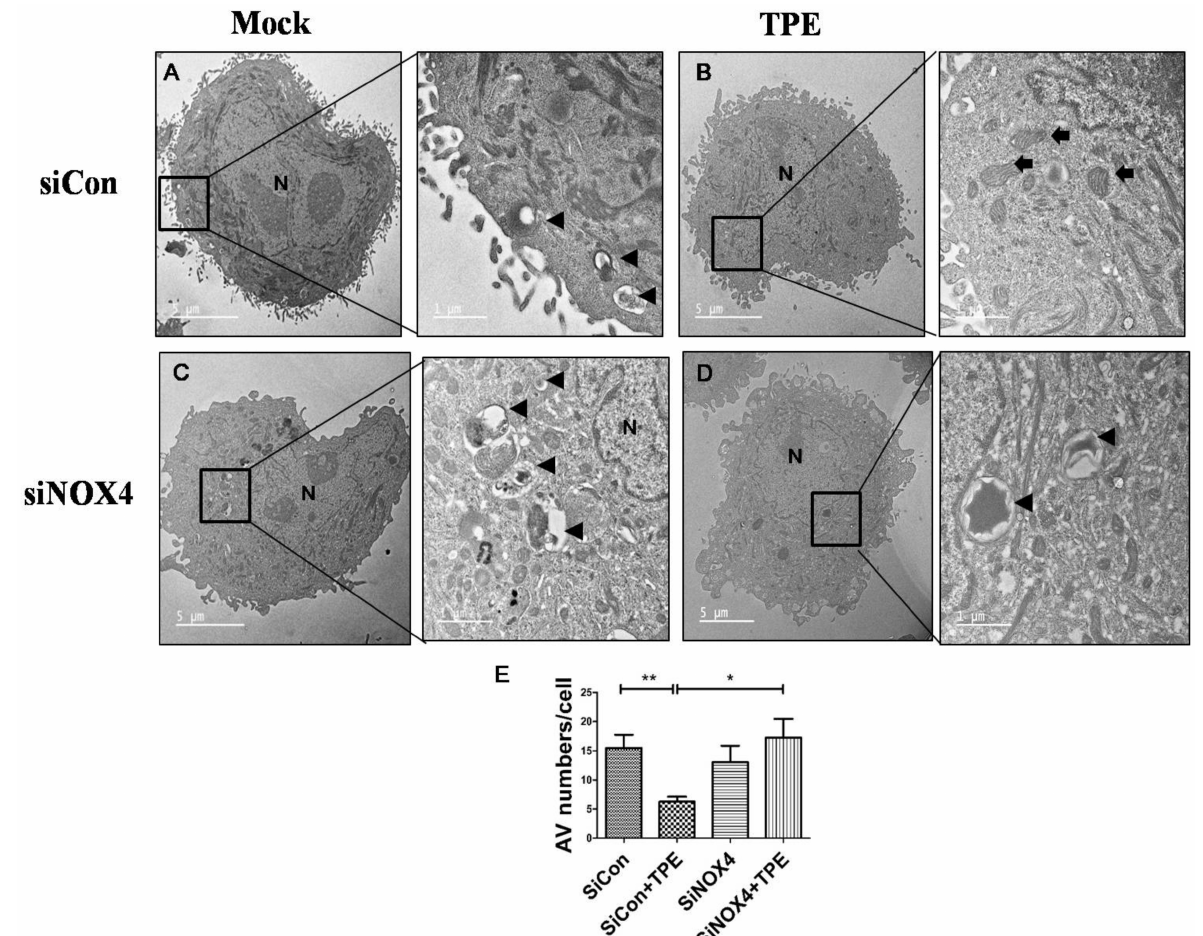
Figure 4. Loss of NOX4 increases autophagic vesicle abundance in A549 cells with TPE (tuberculous pleural effusion):A549 cells were transfected with siCon or siRNA targeting NOX4 (SiNOX4) for 1 day followed by treatment with or without TPE for 48 h. ( A ) siCon (negative control) group; ( B ) siCon+ TPE group; ( C ) siNOX4 group; ( D ) siNOX4+ TPE group. Abundant autophagic vesicles (AVs) were observed in A549 cells but few AVs were observed by transmission electron microscopy following treatment with TPE. Black arrowheads point to AVs including digested material. Black arrows indicate mitochondria. ( E ) The number of autophagic vesicles (AV) in each cell was counted with 5 cells in each sample, respectively. Data indicate the results of three experiments. ** p < 0.01, * p <